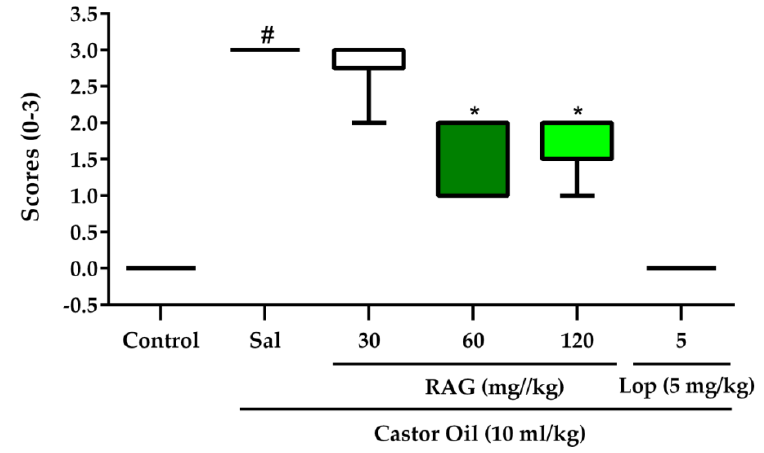
Figure 2. E ff ects of RAG on the fluidity of feces in castor oil-induced diarrhea in mice. Pretreatment with RAG (30 mg / kg) by gavage did not yield statistically di ff erent results compared to the saline + castor oil treatment. However, RAG doses of 60 and 120 mg / kg reduced diarrhea scores and decreased the severity of diarrheal defecation when compared to the control treatment. The standard antidiarrheal drug loperamide (Lop, 5 mg / kg) decreased the production of diarrheal stool significantly. Data are presented as the median and minimum / maximum range. # p < 0.01 vs. saline group; * p <